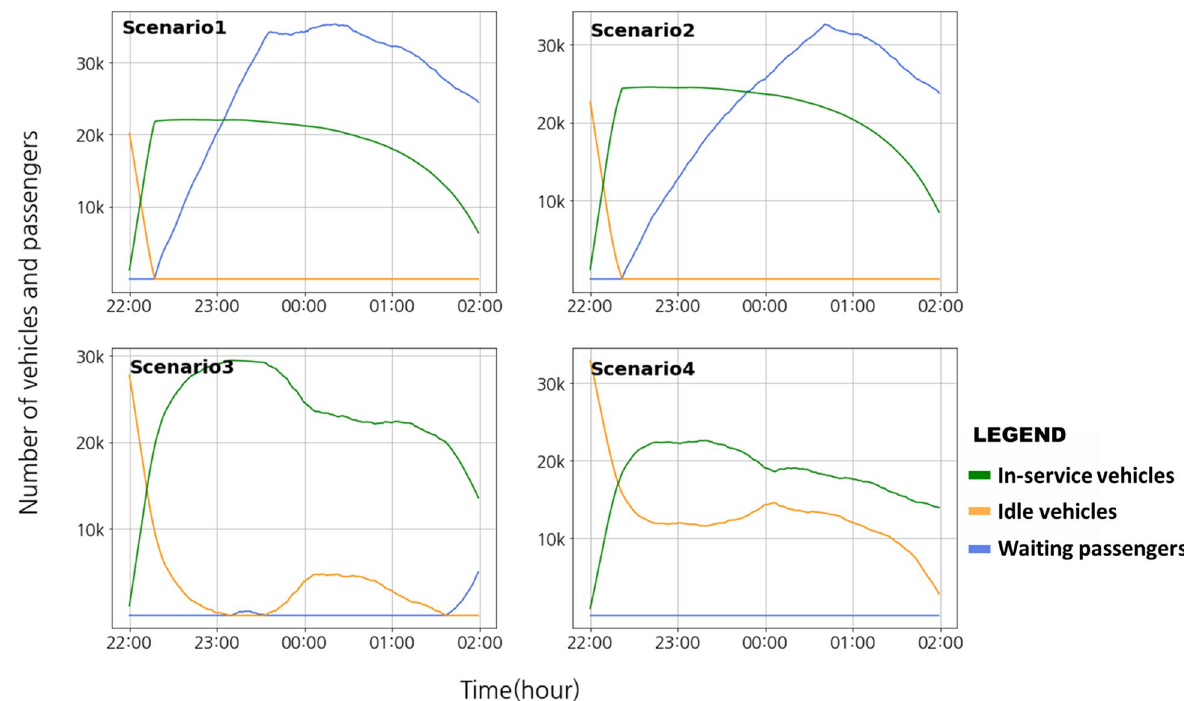
Figure 4. Mobility system operation results by four scenarios in